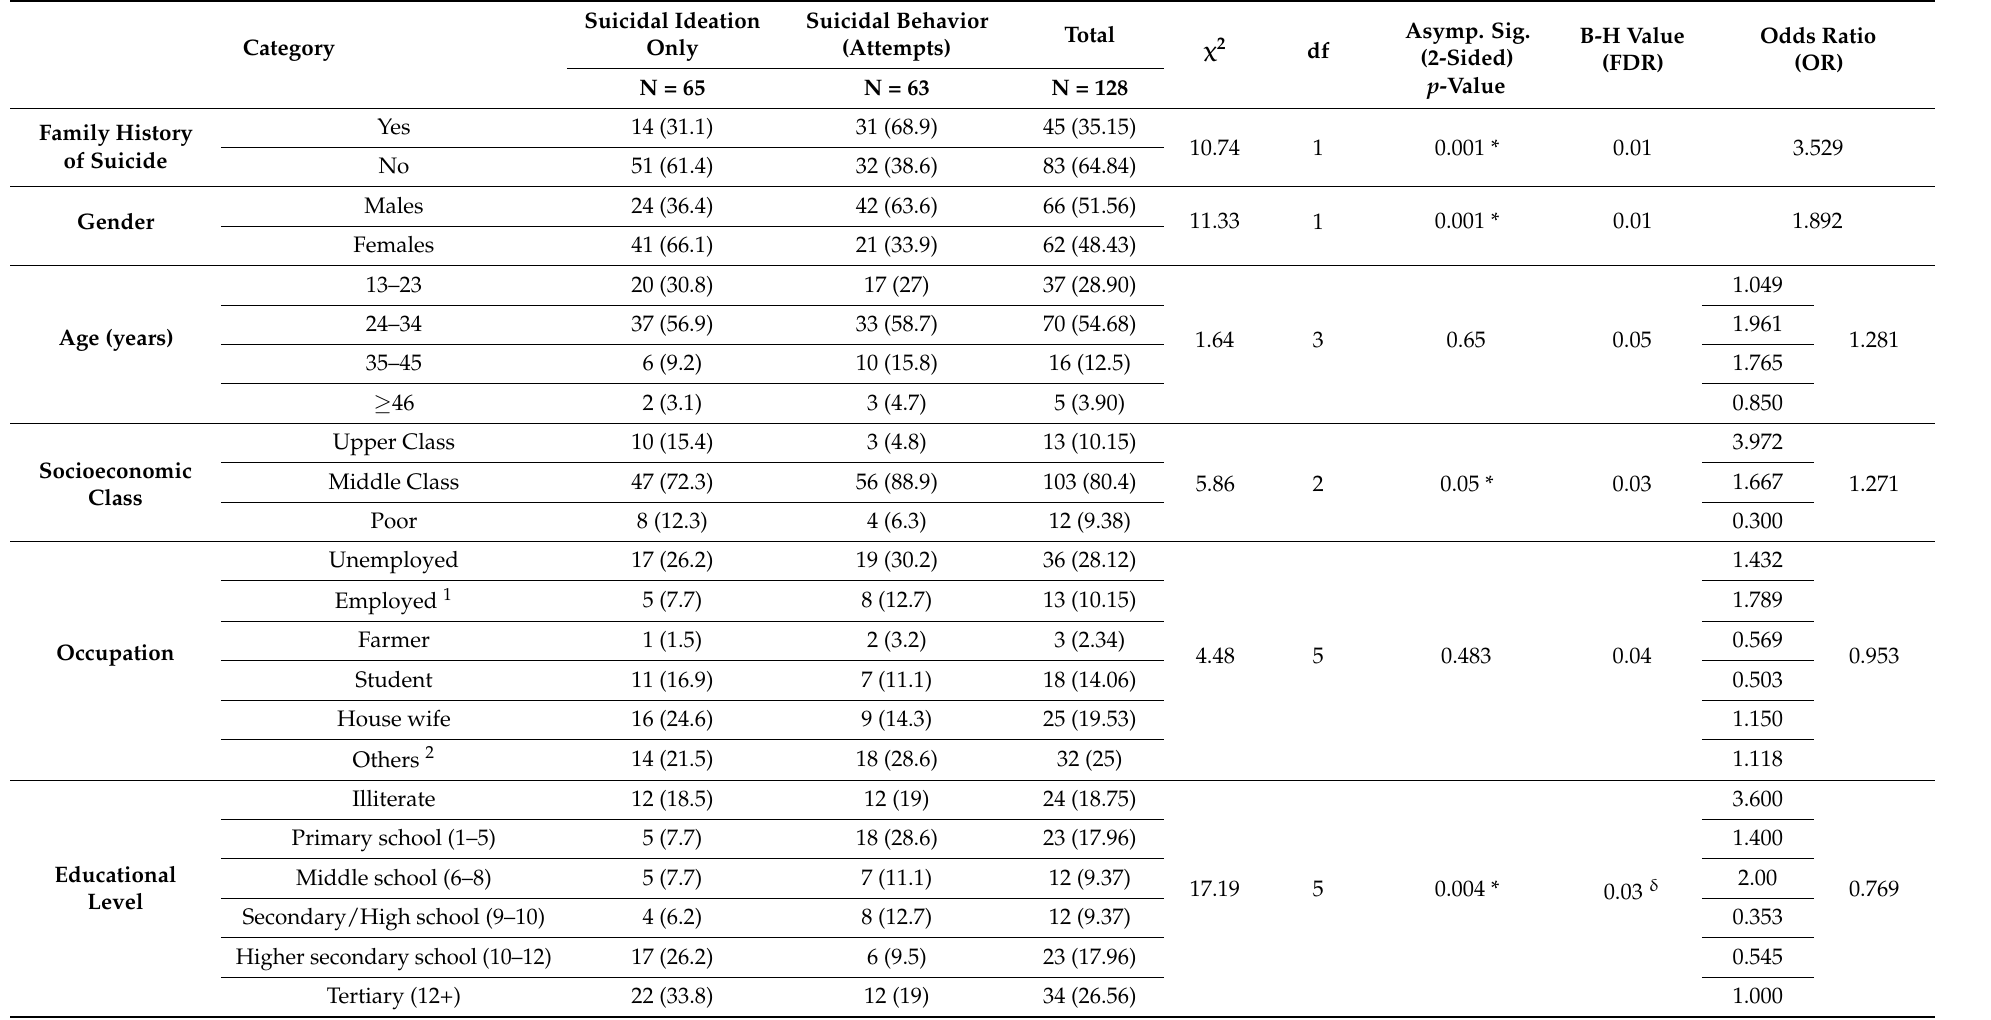
Table 1. Socio-demographic characteristics of the participants included for the assessment of suicidal behavior (N = 128); data is presented as N